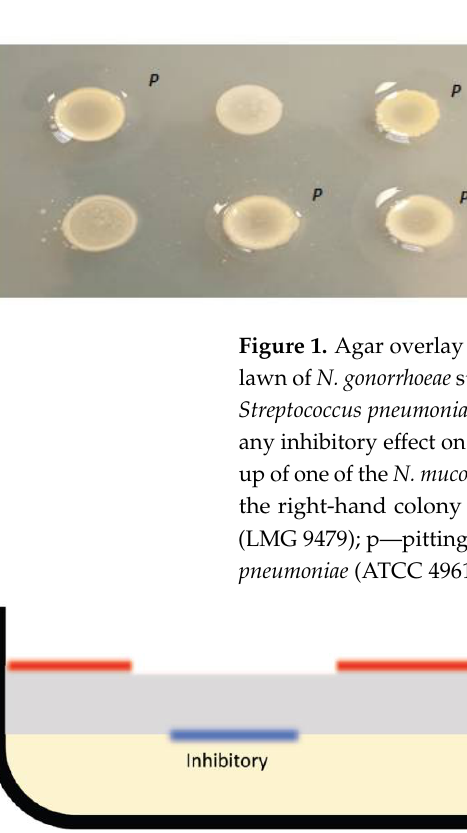
Figure 2. A schematic illustration of the difference between growth-inhibition and pitting in the agar overlay assay. An agar plate in cross section is depicted, on which 3 bacterial colonies (labeled ‘inhibitory’, ‘non-inhibitory’ and ‘pitting’) were spotted and incubated for 24 h before a layer of GCB agar containing 10 6 CFU/mL of N. gonorrhoeae was poured over the plate (grey layer). Whilst the ‘non-inhibitory’ colony had no effect on the growth of N. gonorrhoeae (red line), and the ‘inhibitory’ colony had a clear inhibitory effect, the major effect of the ‘pitting’ colony was to repel the second layer of agar, thus creating an area around it which appears more translucent from above. Close visual inspection, including from the lateral aspect, of the depressed sections of the second layer of agar around the ‘pitting’ colony revealed the uninhibited growth of N. gonorrhoeae .